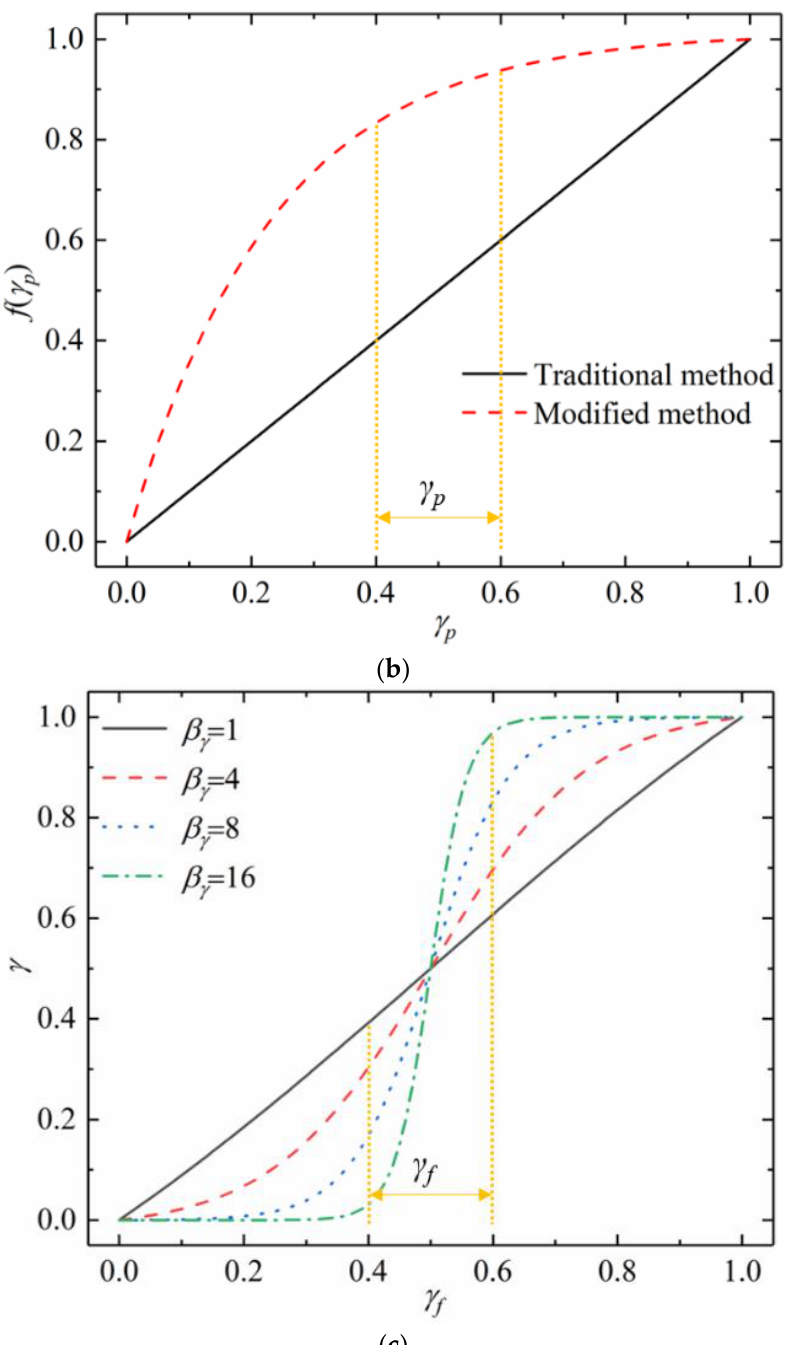
Figure 2. Interpolation function and hyperbolic tangent projection. ( a ) Effect of penalty factor on interpolation function; ( b ) comparison of two interpolation functions; and ( c ) effect of projection slope on hyperbolic tangent function.